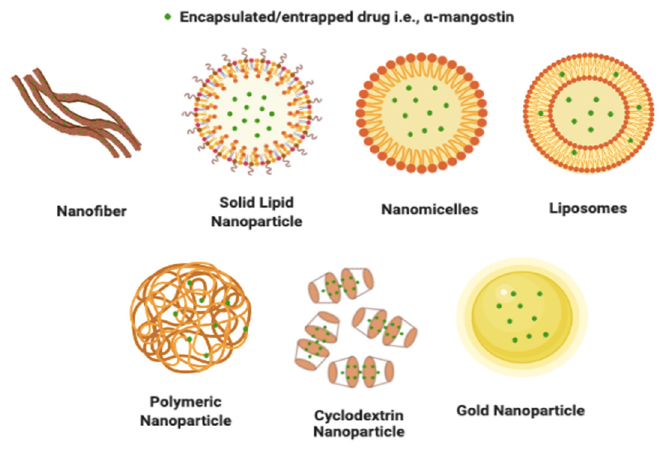
Figure 5. Nanoformulation of α -mangostin for cancer drug delivery. Table 2. Summary of α -mangostin nanoformulations.